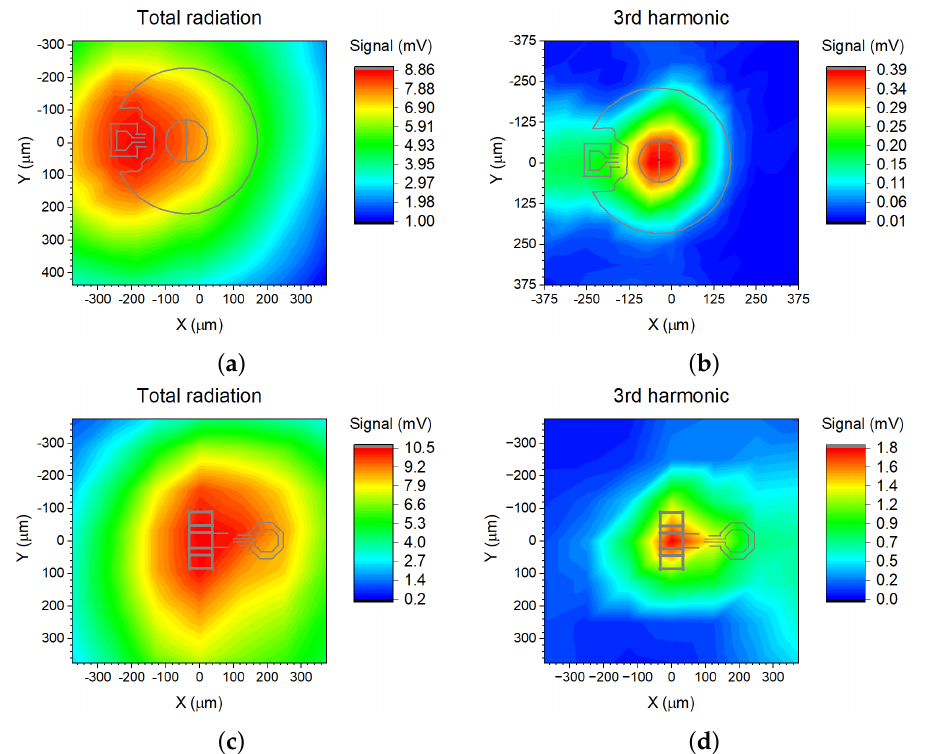
Figure 10. Radiation dependency on the Si lens position on the VCO1 ( a , b ) and the VCO2 crystal ( c , d ). The total radiation was measured using the Golay cell and the point-to-point setup (see Figure 1c). The 3rd harmonic signal was separated using the same Golay cell and WR-03 (220–325 GHz) conical horn antenna. The depicted VCO structures are simplified versions of ones presented in Figure